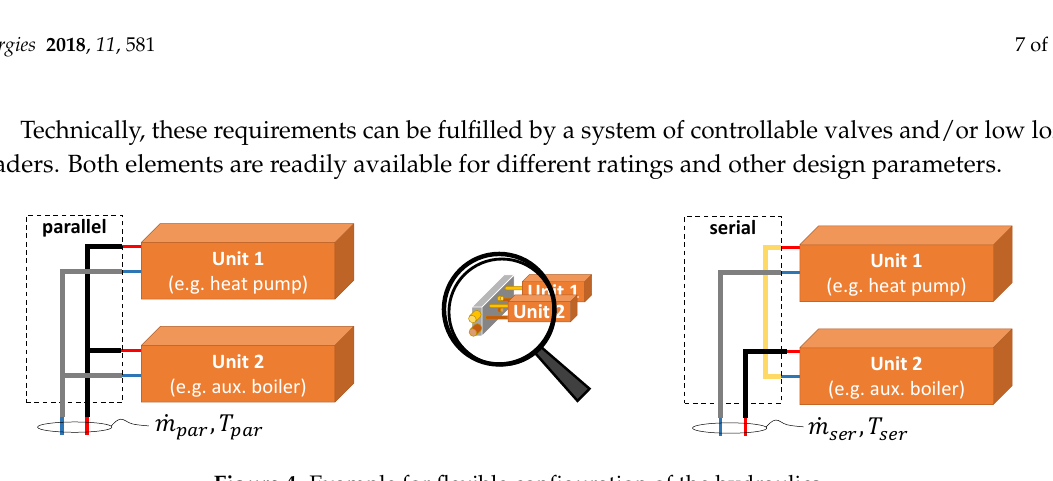
Figure 4. Example for flexible configuration of the hydraulics.